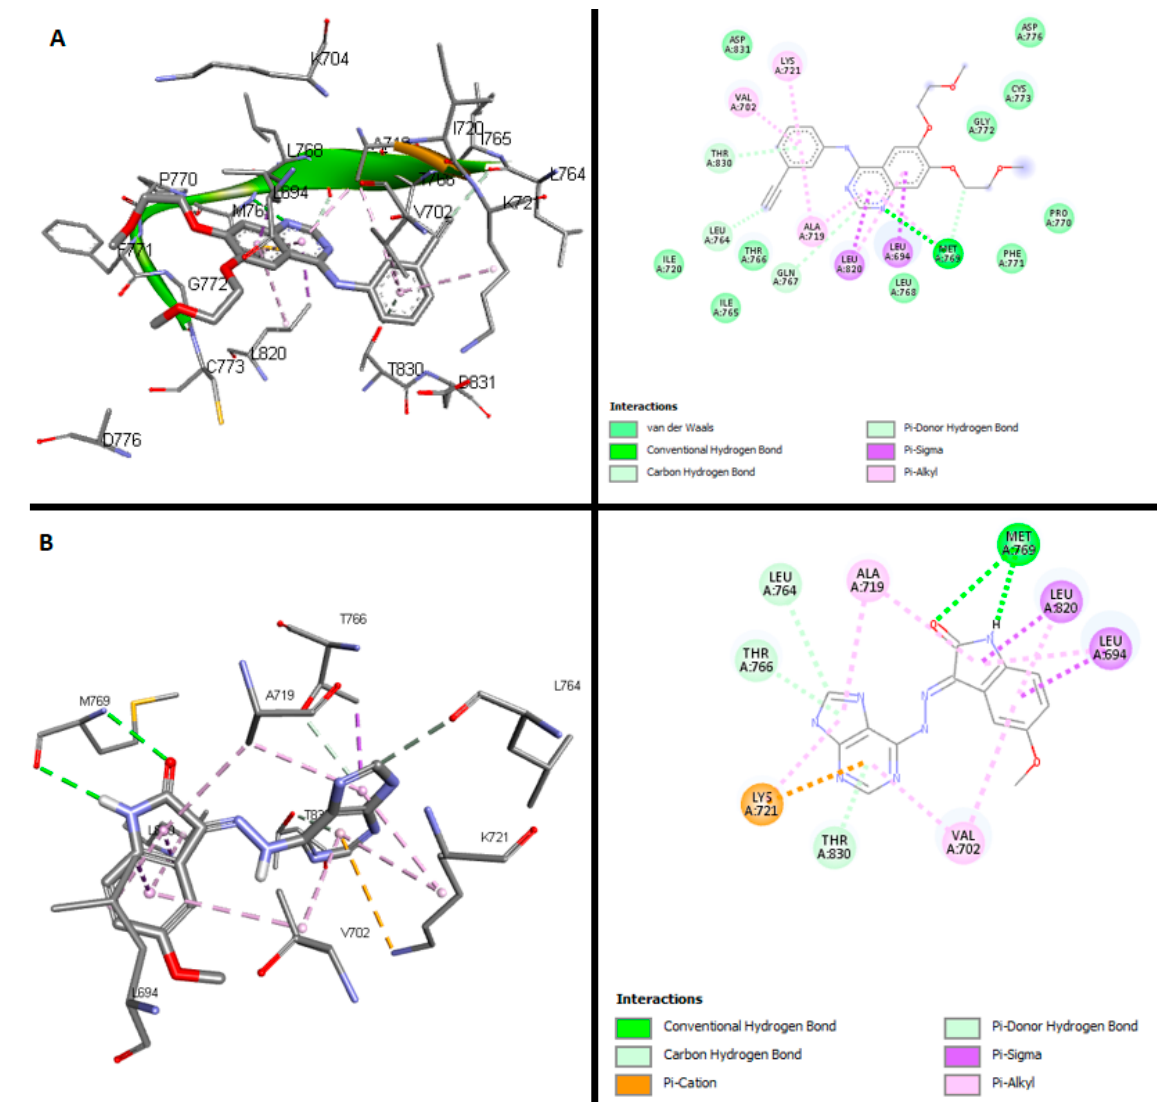
Figure 3. Schematic 2D and 3D representation of docking analysis of erlotinib ( A ) and compound 15 ( B ) in the active site of EGFR (PDB ID: 4HJO).